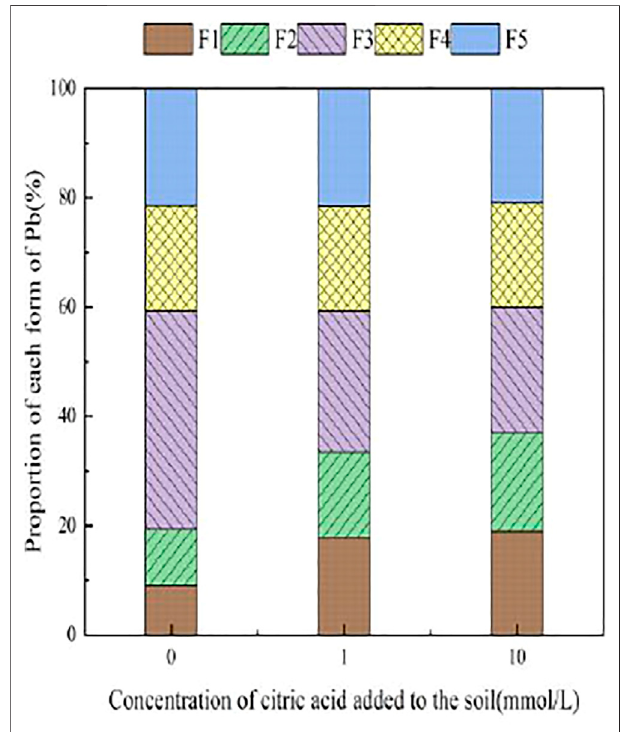
FIGURE 3 | Distribution of Pb form in